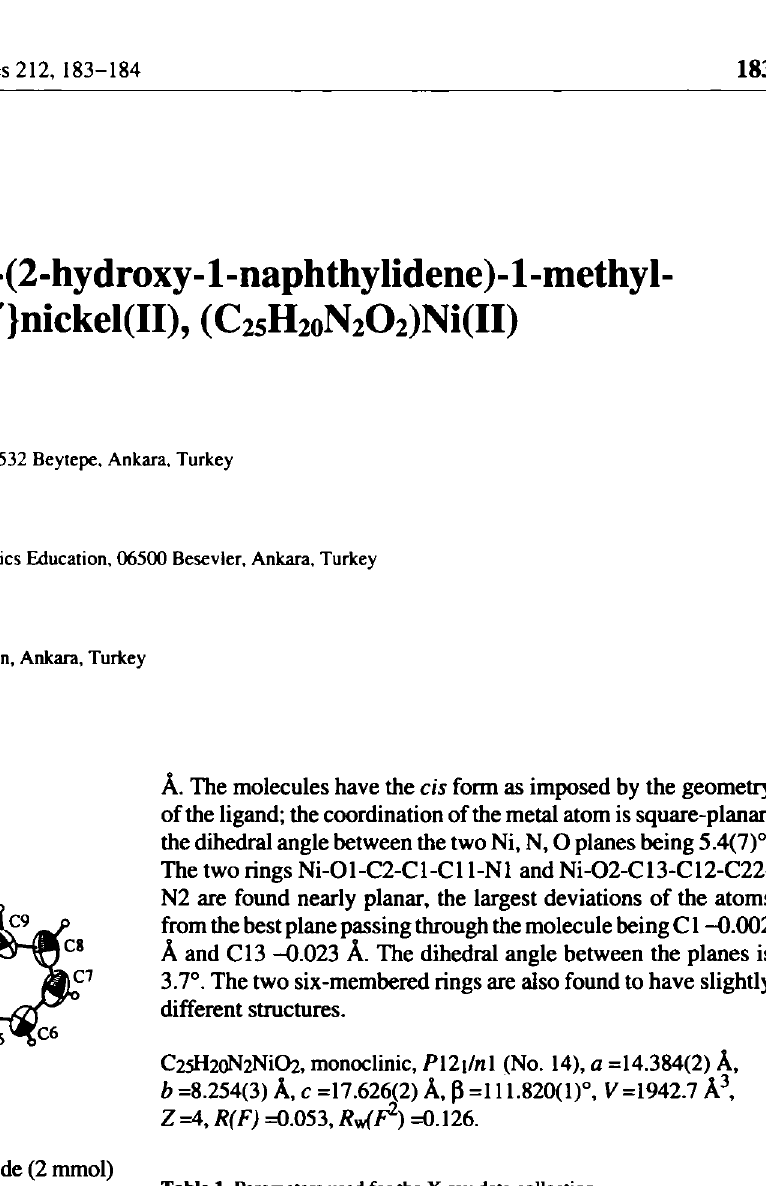
Table 1. Parameters used for the X-ray data collection Crystal: